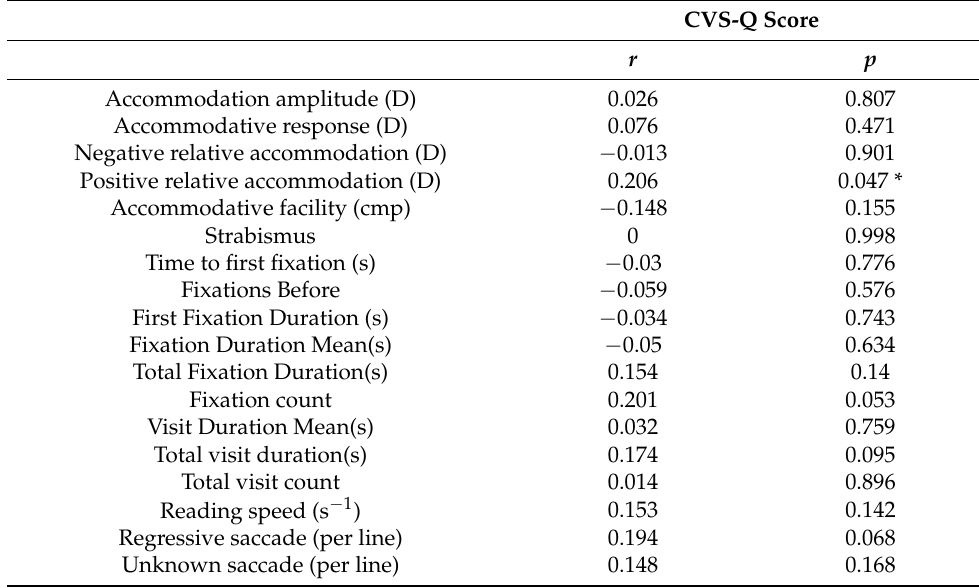
Table 1. Correlations between total CVS-Q score and accommodation and eye